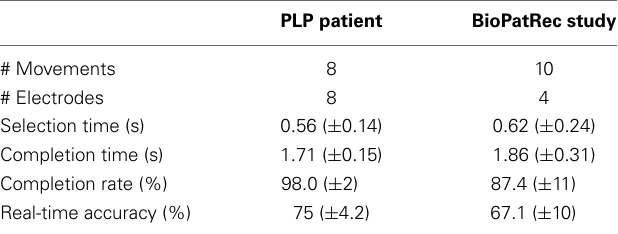
Table 1 | Motion test results.